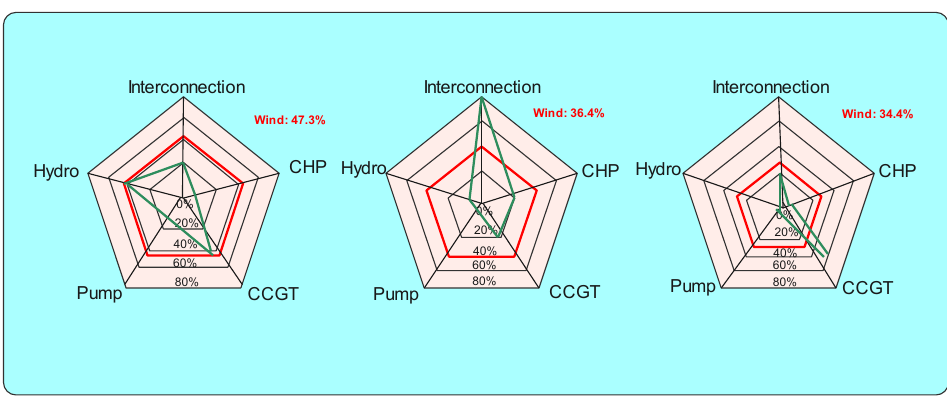
Figure 8. Frameworks and metrics charts for measuring